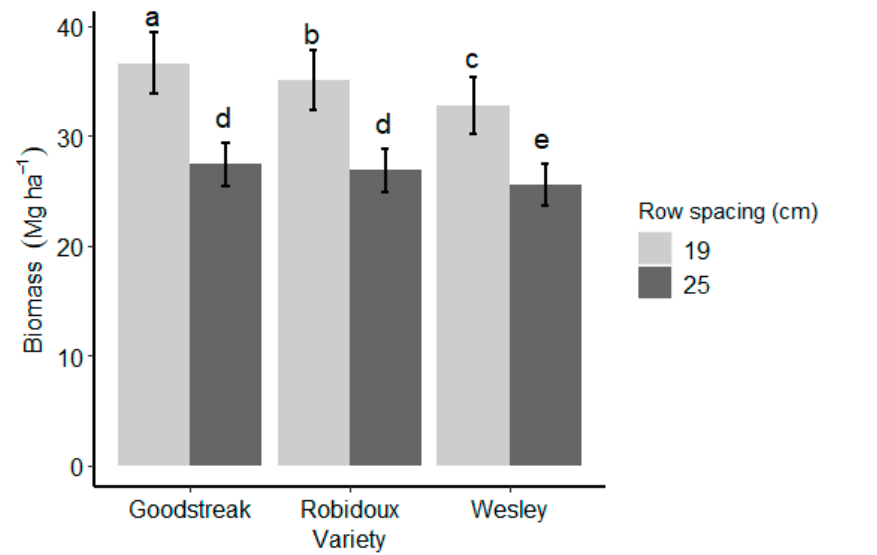
Figure 7. The effect of row spacing × variety interaction on the biomass of winter wheat at Sidney. The error bars represent the standard error of the mean. Different letters on top of column bars indicate a significant mean difference at p < 0.05.